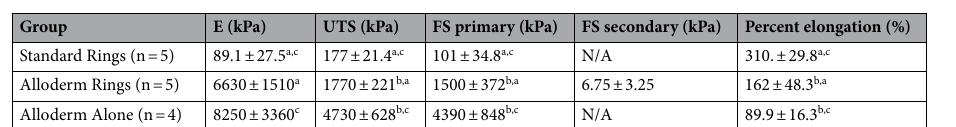
Table 1. Average circumferential ring mechanical properties. a Statistically significant difference between standard rings and Alloderm rings (E: p ≤ 0.0010; UTS: p < 0.0001; FS Primary: p < 0.01; Percent Elongation: p < 0.001). b Statistically significant difference between Alloderm rings and Alloderm alone (E: not significant; UTS: p < 0.0001; FS Primary: p < 0.0001; Percent Elongation: p < 0.05). c Statistically significant difference between standard rings and Alloderm alone (E: p < 0.0001; UTS: p < 0.0001; FS Primary: p < 0.0001; Percent Elongation: p < 0.001).